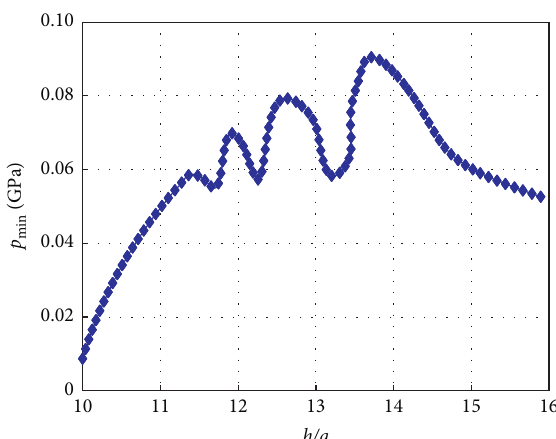
Figure 9: Relationship between p